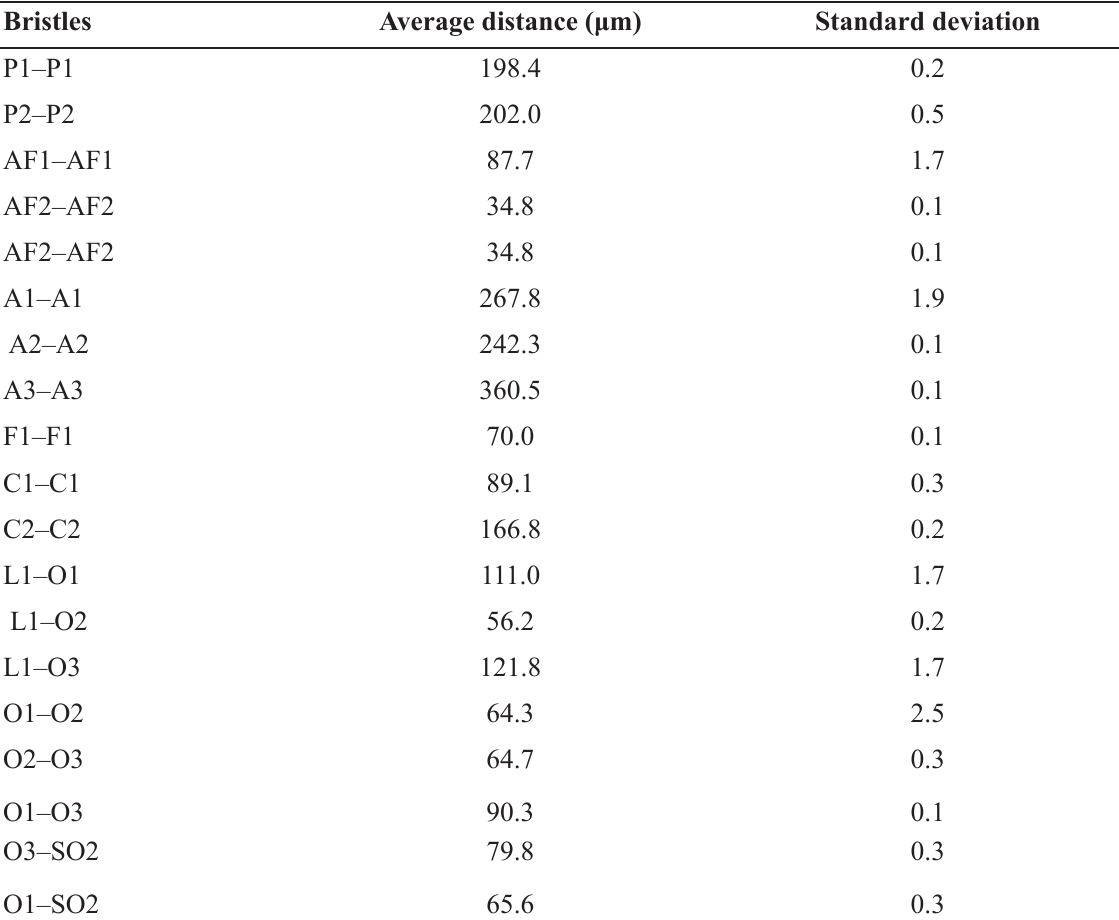
Table 5. Distance between the bristles on the head capsule of M. shahvarica sp.